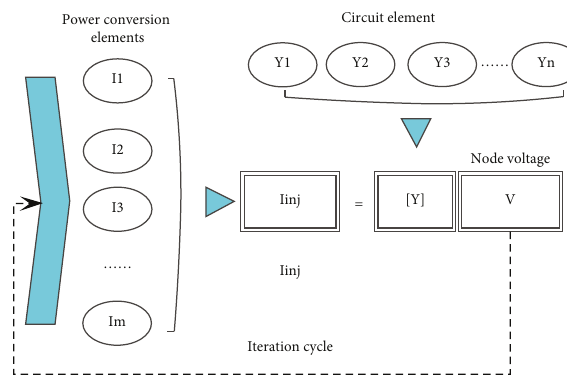
Figure 2: Iterative cycle diagram of OpenDSS when calculating power